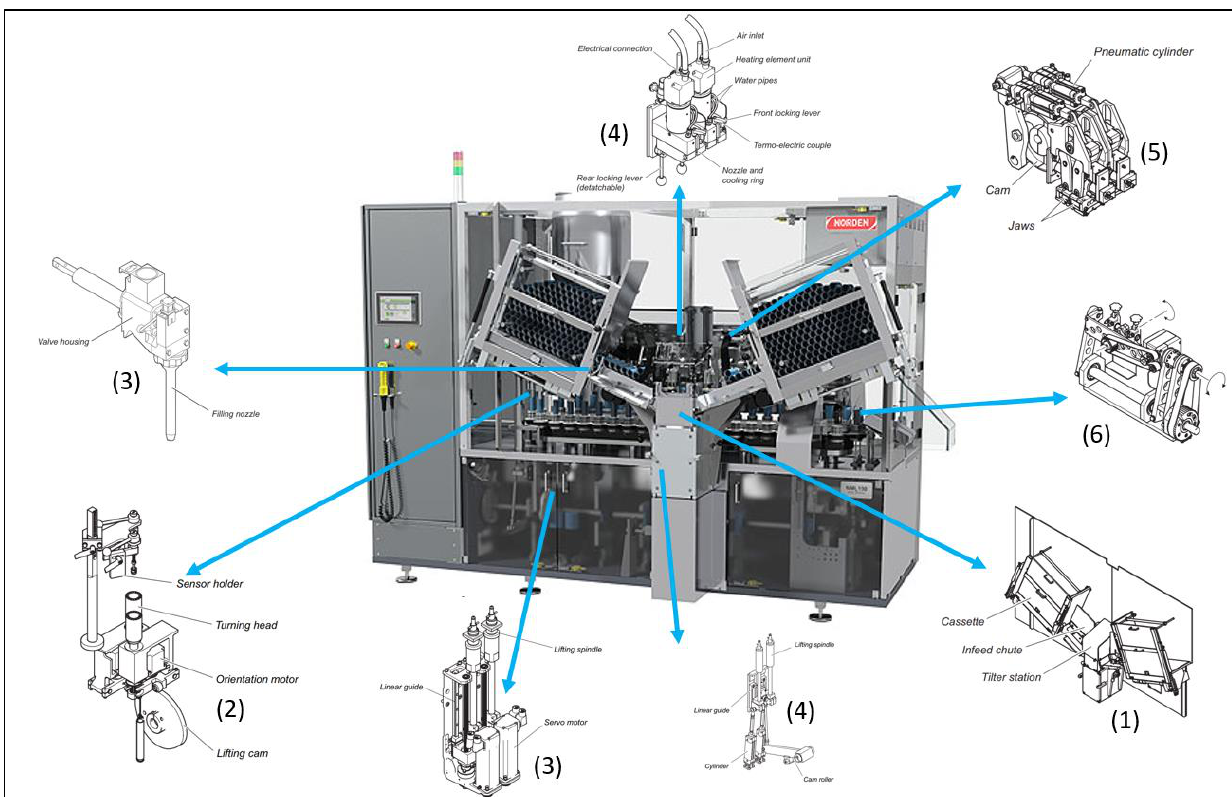
Figure 1. Tube filling machine with component list: (1) Tube infeed, (2) Tube orientation, (3) Tube filling, (4) Hot air station, (5) Tube sealing, (6) Pick and place unit [20].